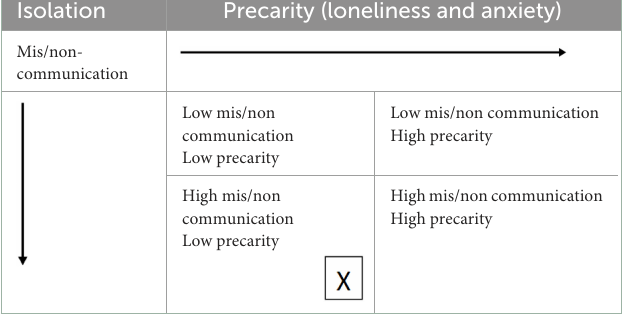
TABLE 5 Evolution of typology, step 2b–Health and precarity. Health